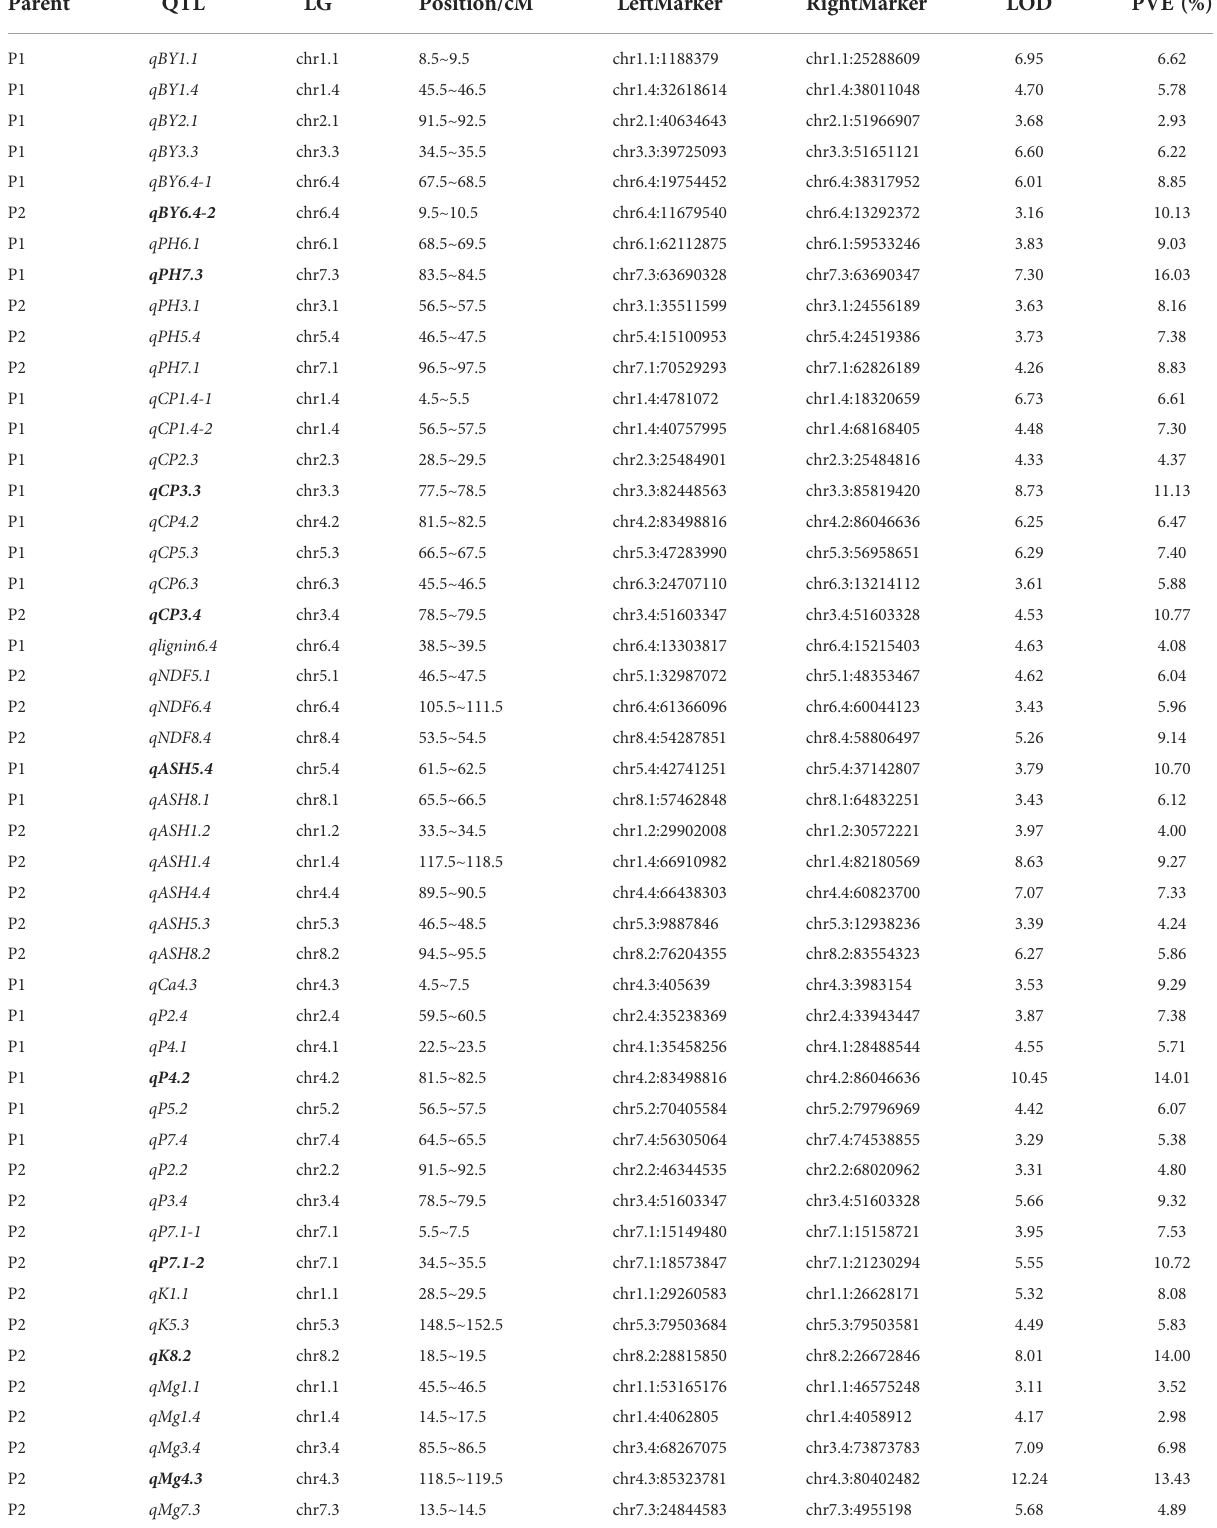
TABLE 1 QTLs detected for 12 traits using ICIM-ADD in the F1 population. Parent QTL LG Position/cM LeftMarker RightMarker LOD PVE